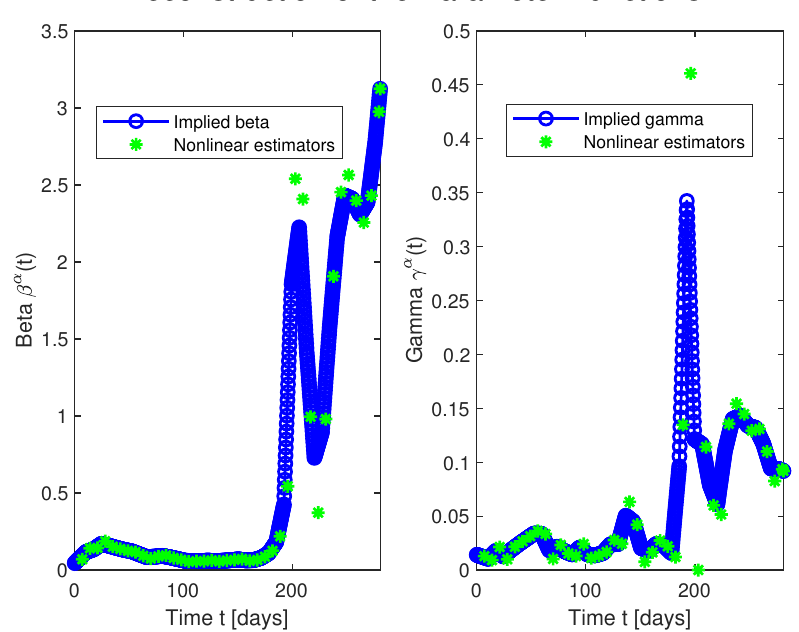
Figure 11. Recovered parameters β α ( t ) and γ α ( t ) for α = 0.9437255859375.